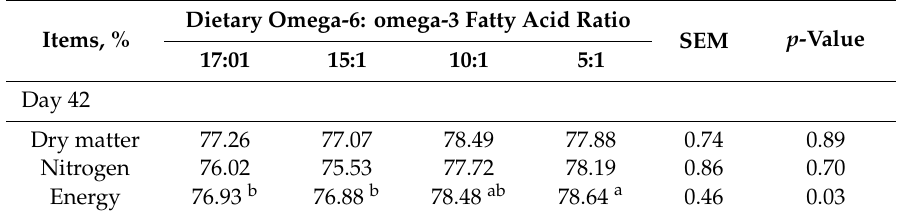
Table 4. E ff ect of omega-6: omega-3 fatty acid ratio on nutrient digestibility in growing